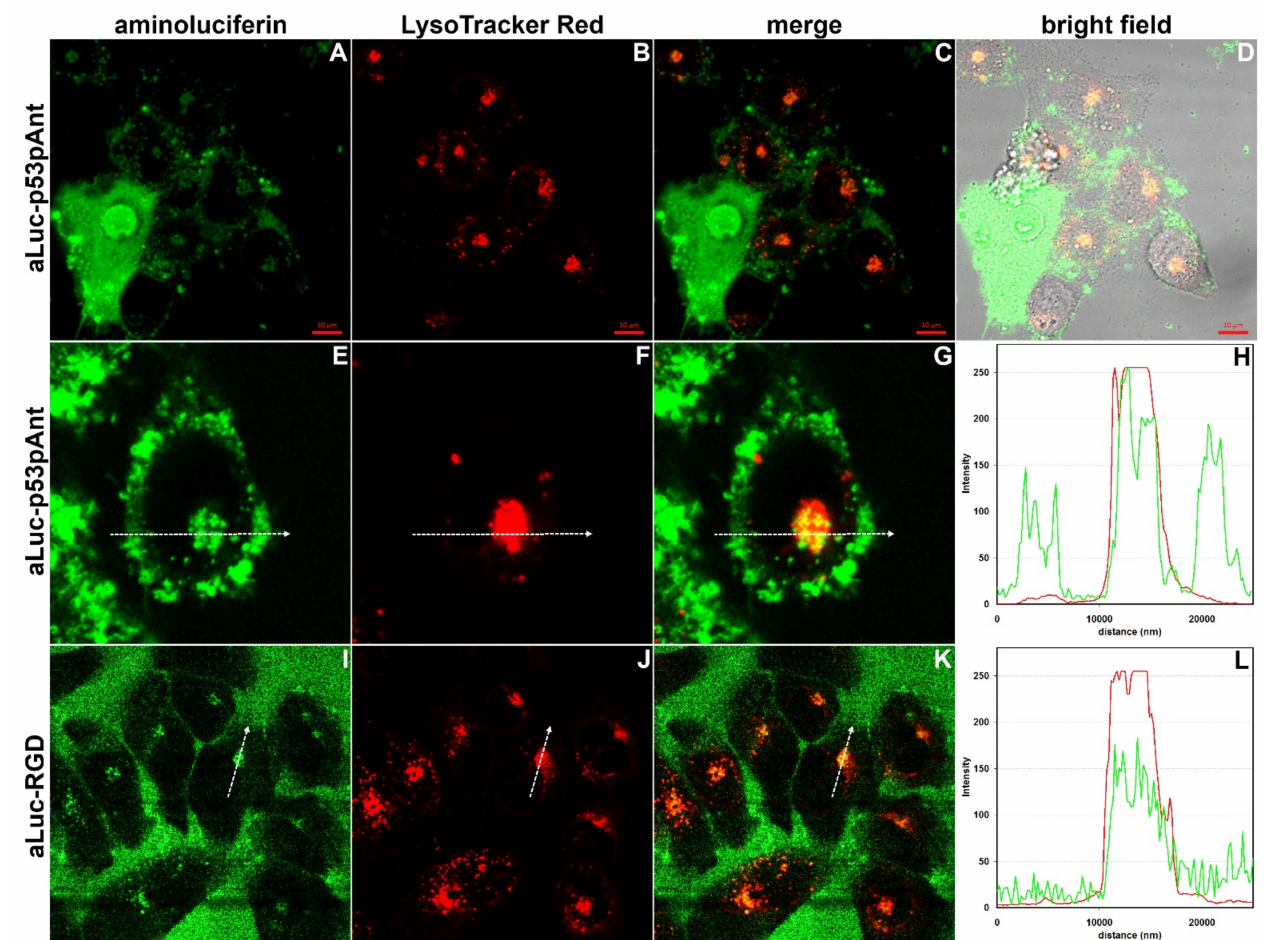
Figure 7. CLSM images of HaCaT cells treated with aLuc-p53pAnt or aLuc-RGD. ( A – D ) Cells were incubated with aLuc-p53pAnt for 120 min and with LysoTracker™ Red DND-99 for 15 additional minutes. Bar = 10 µ m. ( E , F ) Single representative HaCaT cell treated with aLuc-p53pAnt (from Figure S14A–D). White arrow = 25 µ m. ( I – K ) Cells were incubated with aLuc-RGD for 90 min and with LysoTracker™ Red DND-99 for 15 additional minutes (bright field in Figure S16E). White arrow = 25 µ m. ( H , L ) Fluorescence intensity across the white arrows in panels ( E – G ) and ( I – K ), respectively (green curve, aLuc; red curve, LysoTracker